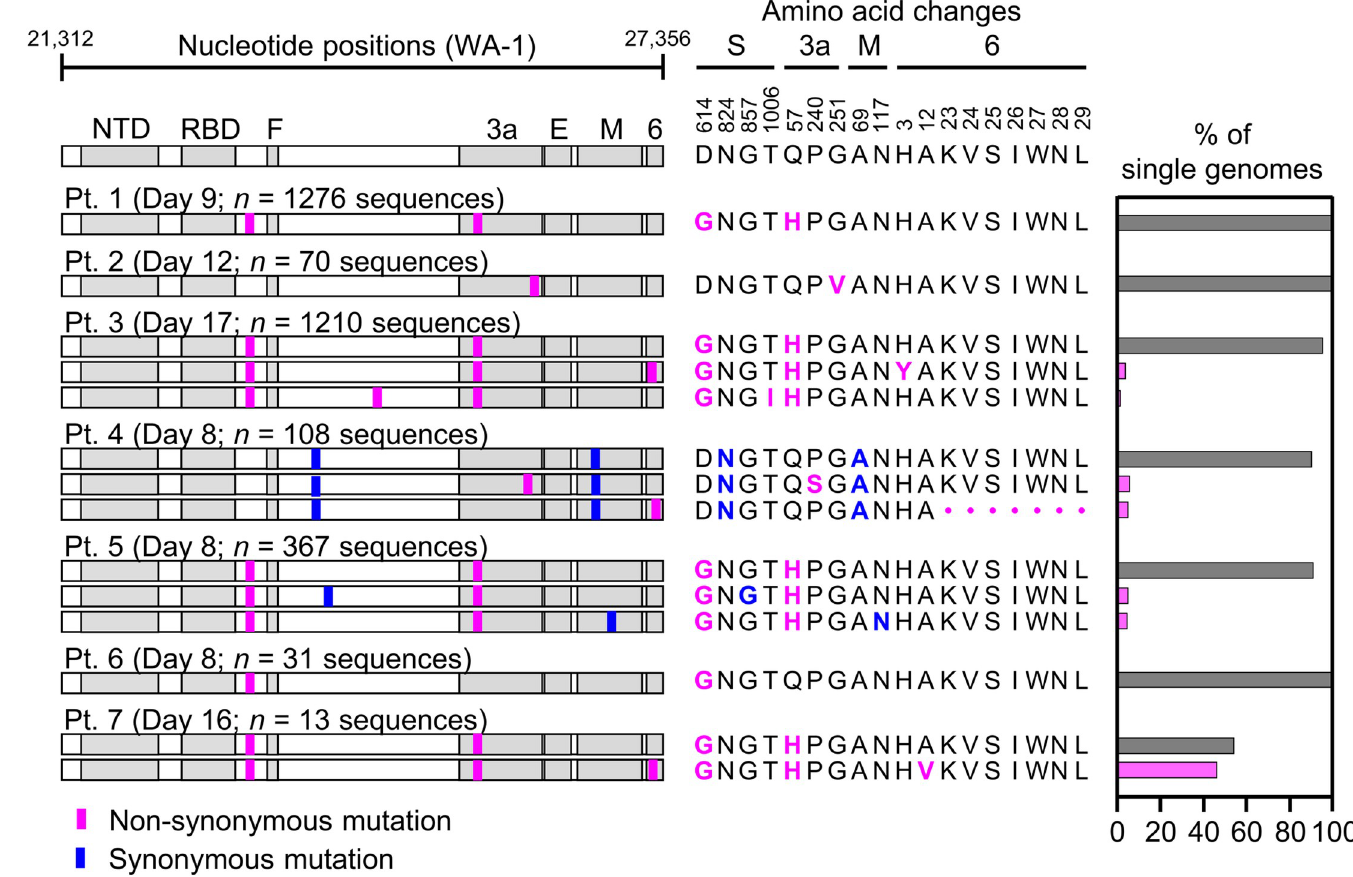
Fig 3. Variant haplotypes of the SARS-CoV-2 virion surface protein gene region detected in upper respiratory tract samples from 7 hospitalized study participants with COVID-19. Each participant label indicates day of clinical illness and the number of SGS obtained for the sample in parentheses. Haplotype diagrams (left) depicting SARS-CoV-2 SGS are as in Fig 2. Non-synonymous or synonymous mutations in each haplotype relative to the WA-1 reference sequence are shown with pink or blue tick marks. Amino acid changes (middle) and percentages of all SGS in the sample attributable to indicated haplotypes (right) are as in Fig 2. The haplotype matching the consensus for each sample is represented in grey; variant haplotypes with at least 1 non-synonymous mismatch to sample consensus are in pink.